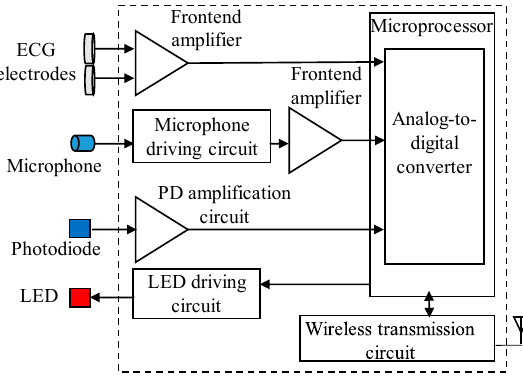
Figure 2. Block diagram of the wireless biosignal acquisition module.